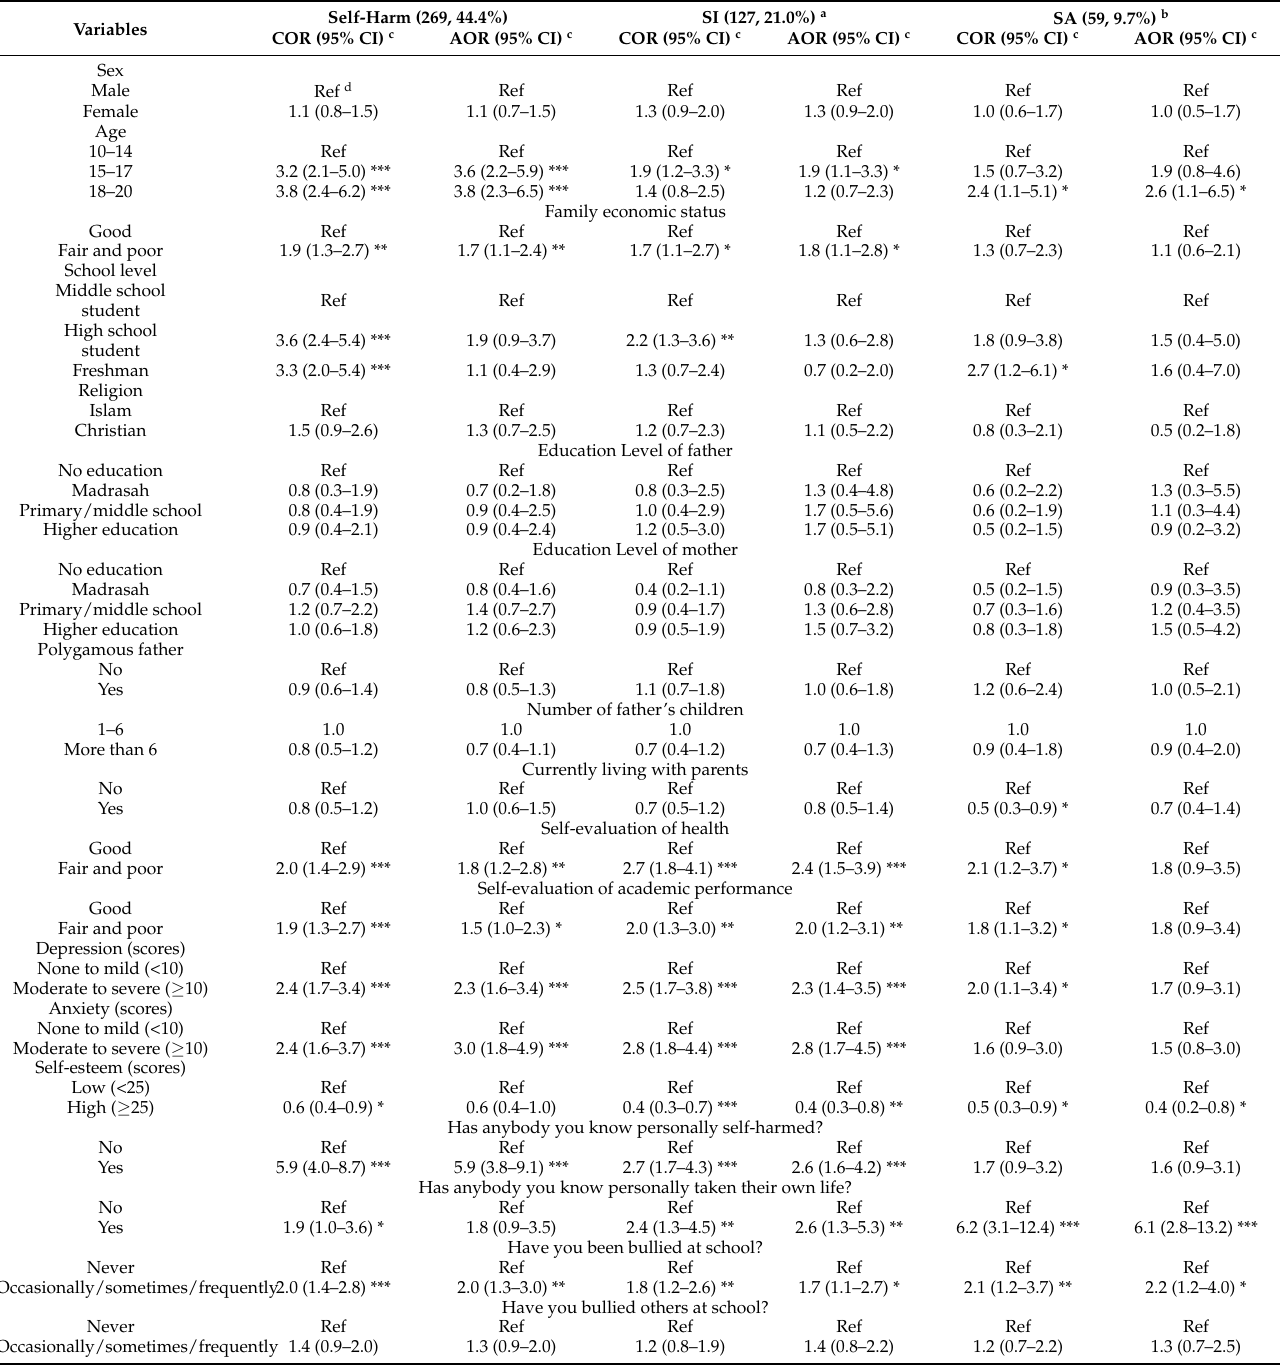
Table 4. Logistic regression for predictors of self-harm, SI and SA among